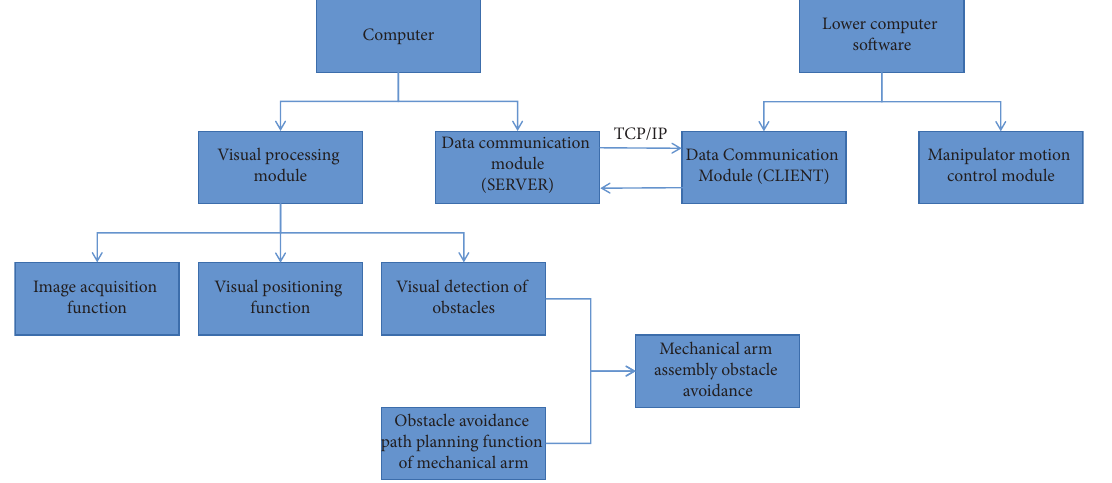
Figure 3: Software architecture of the robot visual assembly